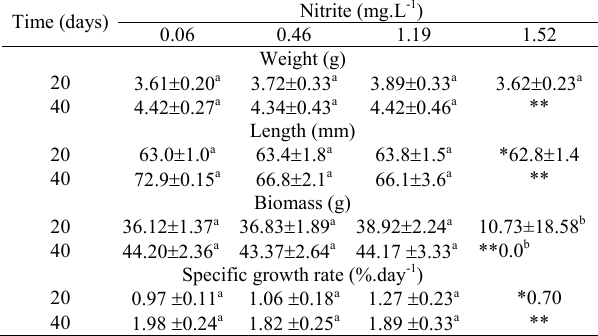
Table 1. Effect of waterborne nitrite on weight, length, biomass and specific growth rate of silver catfish juveniles. N = 3 tanks.Values are expressed as mean ± SEM. Different letters in the rows indicate significant difference among treatments by one-way ANOVA and Tukey test (p<0.05).* = only one replicate; ** = all fish